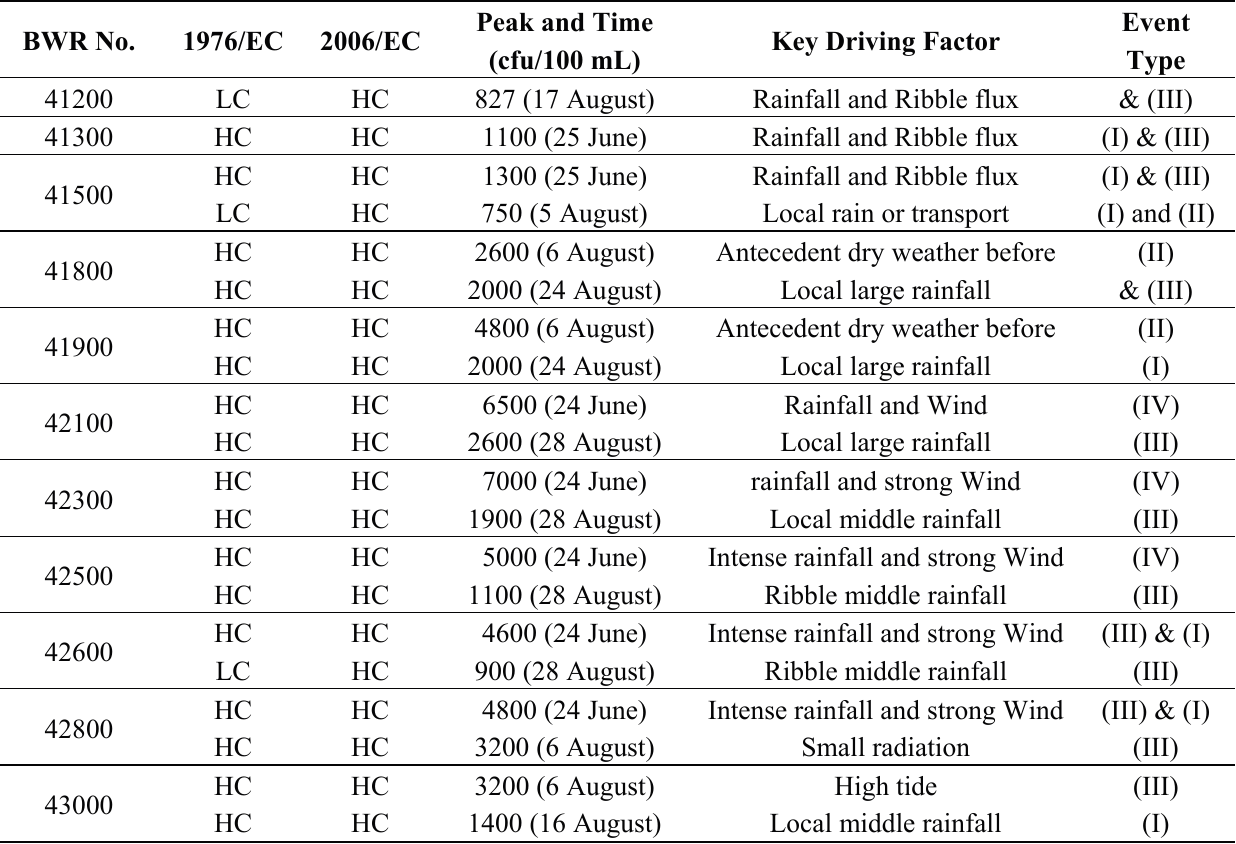
Table 3. High E. coli concentration events and the key identified impact factors at 11 bathing water compliance sites (see Figure 1 for